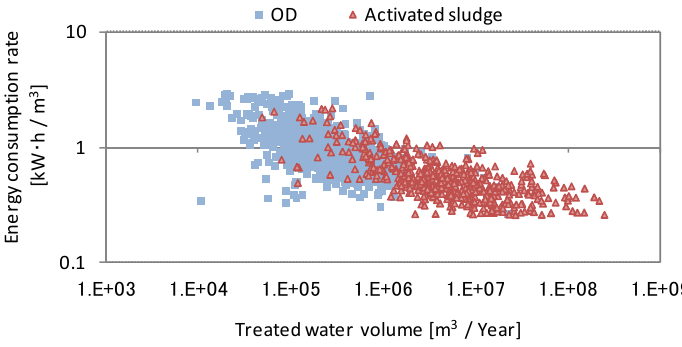
Figure 13. Relationship between energy consumption rates and treated wastewater volumes for sewer systems in